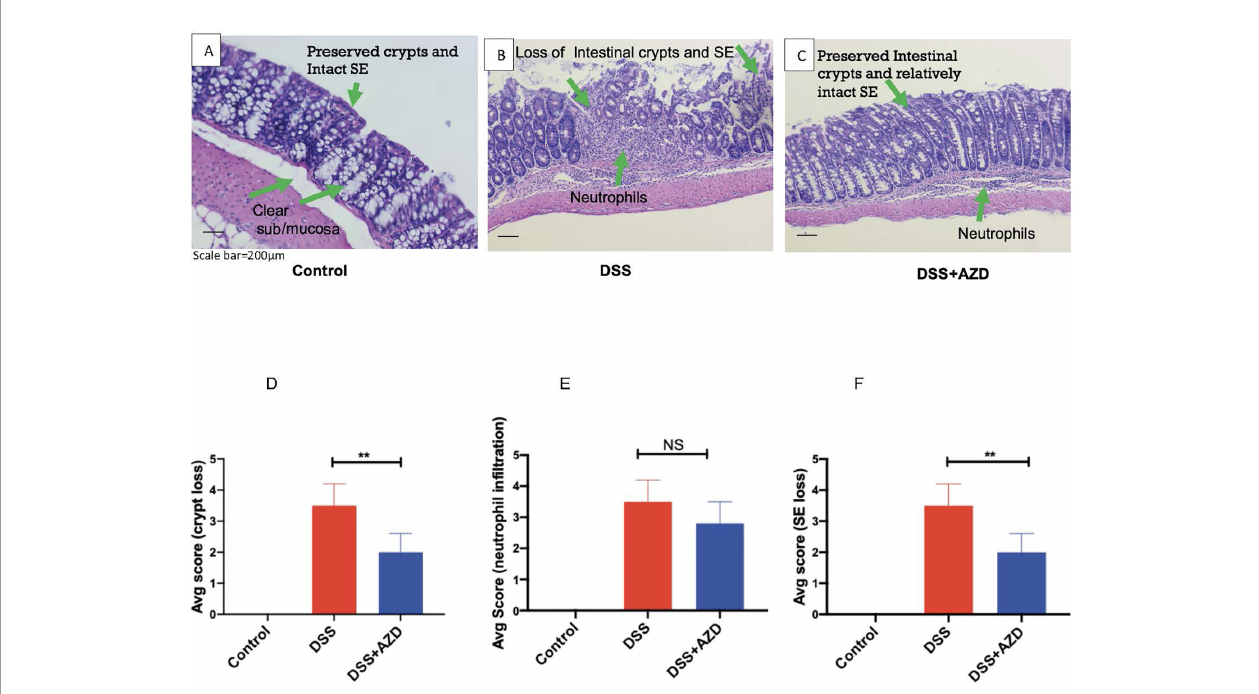
FIGURE 5 | Representative histopathological images of mouse colon sacri fi ced and stained with Harris hematoxylin and counter stained with eosin after 9 days of dextran sodium sulfate (DSS) challenge. Mice were randomly divided into three treatment arms over 9 days i) vehicle group (n = 5) given normal drinking water and peanut butter without drug; ii) DSS group (n = 5) given 2% w/v DSS in drinking water and peanut butter without drug; iii) DSS+AZD3241 (n = 5) given 2% w/v DSS in drinking water and AZD3241 @ 30 mg/kg in peanut butter. The extent of (A) Crypt loss (B) neutrophil in fi ltration and (C) surface epithelium loss was assessed microscopically against the scoring criteria de fi ned and in Table 1 and is presented in (D – F) , respectively. **Different to the DSS+AZD3241, ( p < 0.001). AZD3241 is abbreviated to AZD in this fi gure.